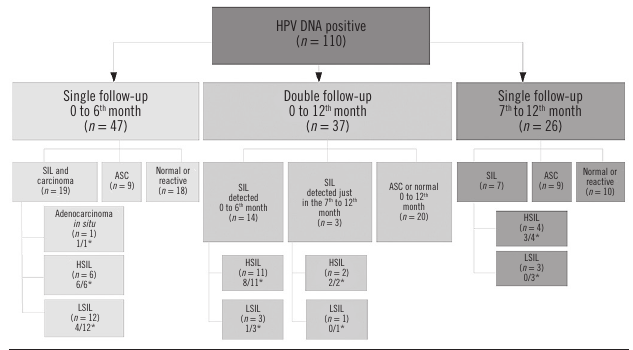
figure 1 – Distribution of HPV-positive by hybrid capture cases for histological or colposcopy evaluation outcome within one-year of follow-up after identification of atypical squamous